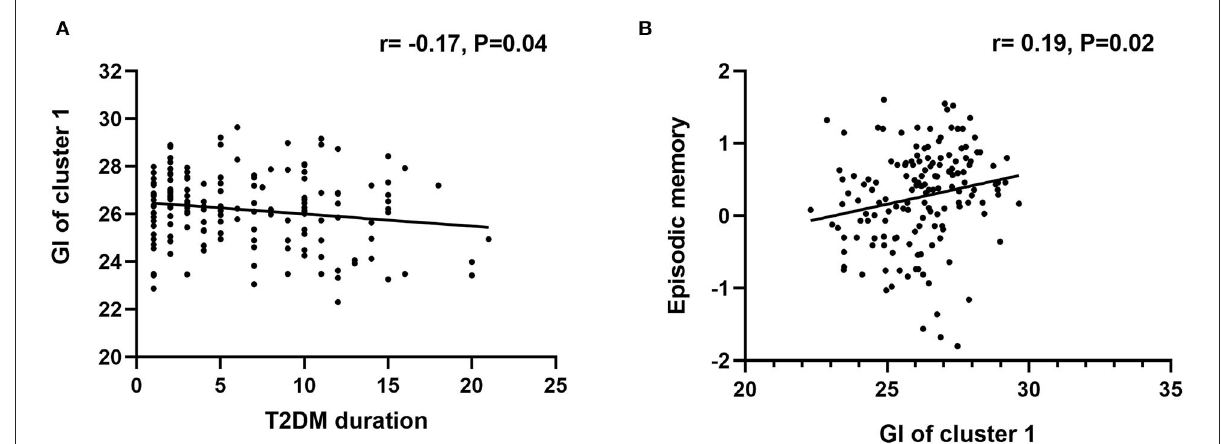
FIGURE4 Correlational analysis in the T2DM-NC group. (A) Correlation analysis between T2DM duration and GI of cluster 1. (B) Correlation analysis between GI of cluster 1 and episodic